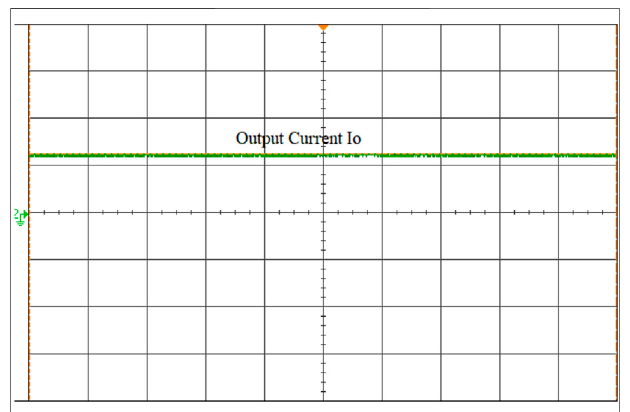
FIGURE 19 | Output current of the ISC